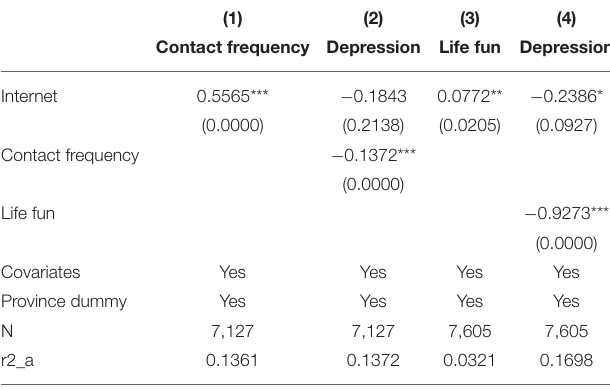
TABLE 6 | Mediating effect of children contact frequency and life